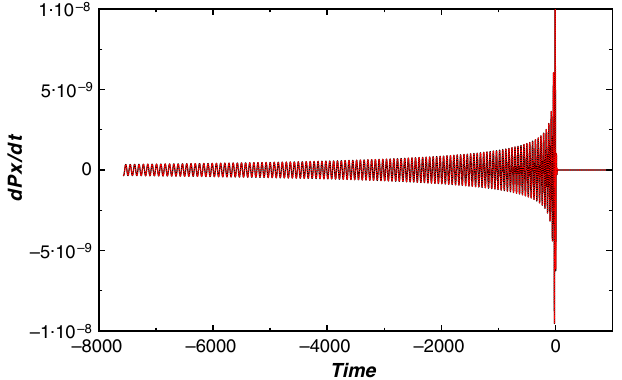
FIG. 4. Linear momentum flux measured at f (cid:2) ¼ S g with the hyperboloidal code (black), and extrapolated to infinity with the Cauchy code (dashed red